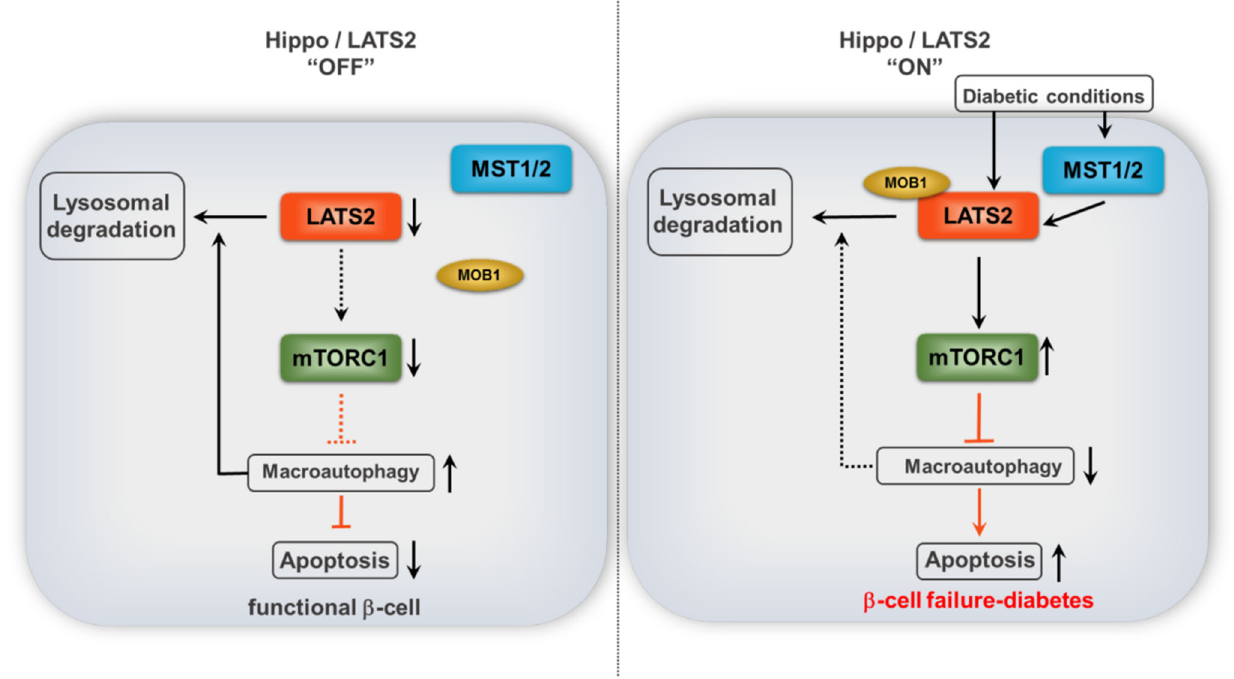
Fig. 9 Proposed model of LATS2 action in β -cells. LATS2, mTORC1, and autophagy may constitute a stress-sensitive survival pathway. Under physiological (Hippo ” OFF ” ) or acute stress conditions, autophagy promotes β -cell survival by directly degrading LATS2 and consequently reinforcing protective-autophagy mechanism through a positive-feedback loop. However, prolonged diabetogenic stress activated LATS2 (Hippo “ ON ” ) leading to mTORC1 hyper-activation, defective autophagy, ultimately further LATS2 accumulation and subsequent β -cell apoptosis. LATS2 (Large tumor suppressor 2; in orange), MST1/2 (Mammalian Sterile 20-like kinases 1/2; in blue), MOB1 (Mps-one binder 1; in beige), mTORC1 (Mammalian target of rapamycin complex 1; in